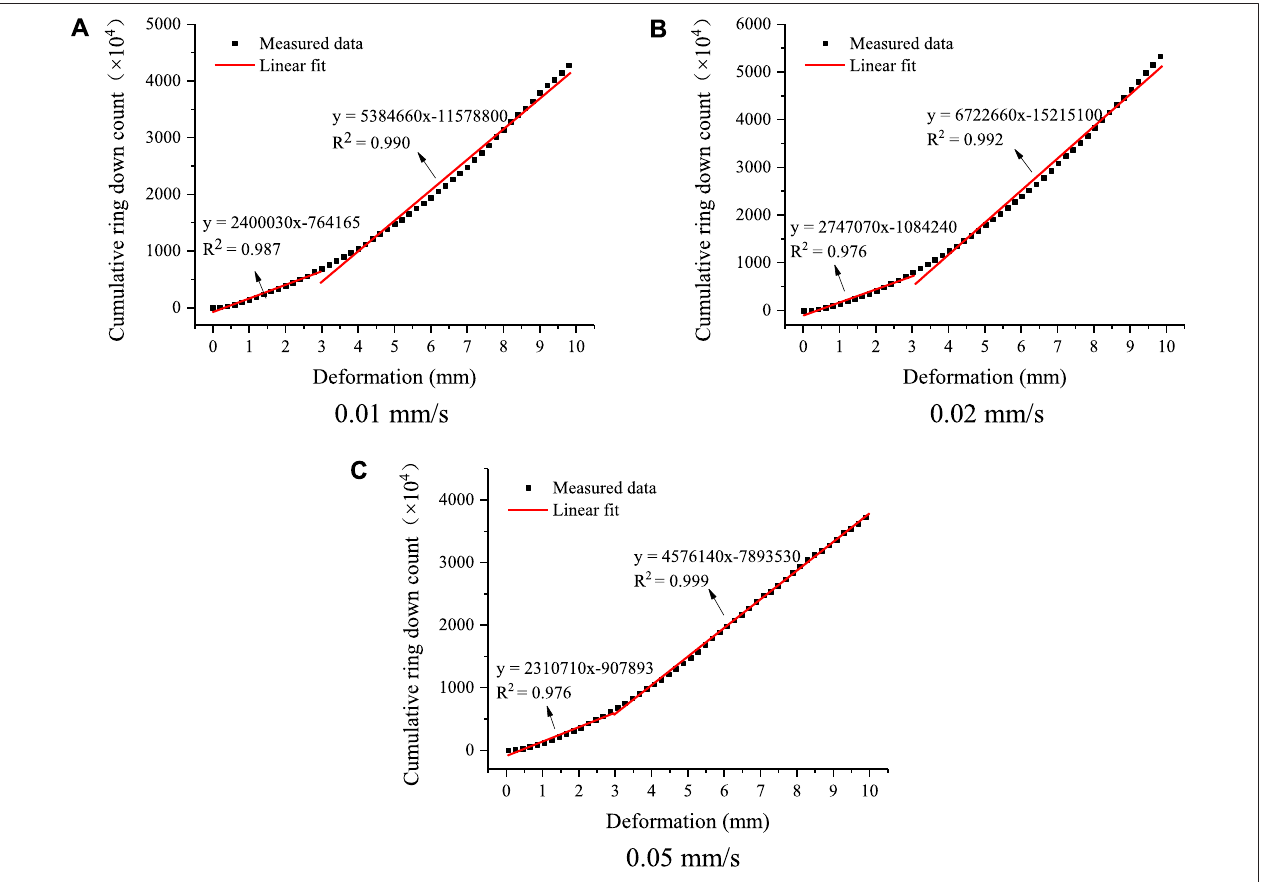
FIGURE 9 | Linear relationship between cumulative ring down count and deformation of “ guided wave meter ” with different deformation rates.